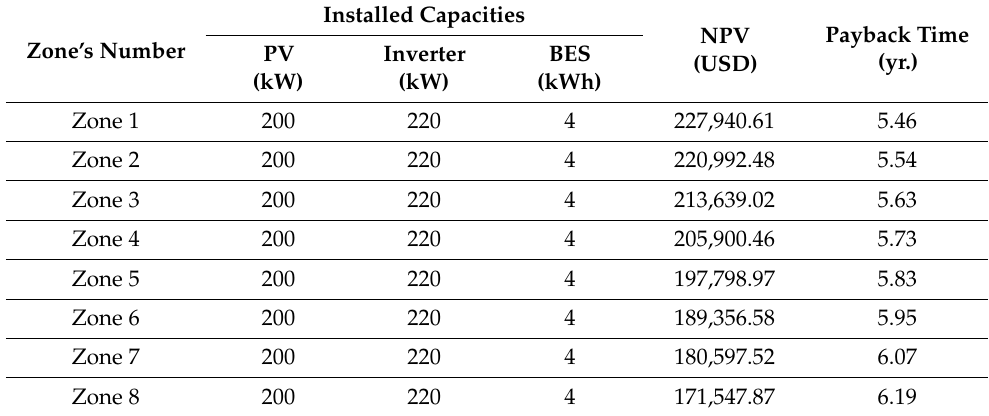
Table 5. The optimized capacity, the NPC, and the payback time of the system in the base case.